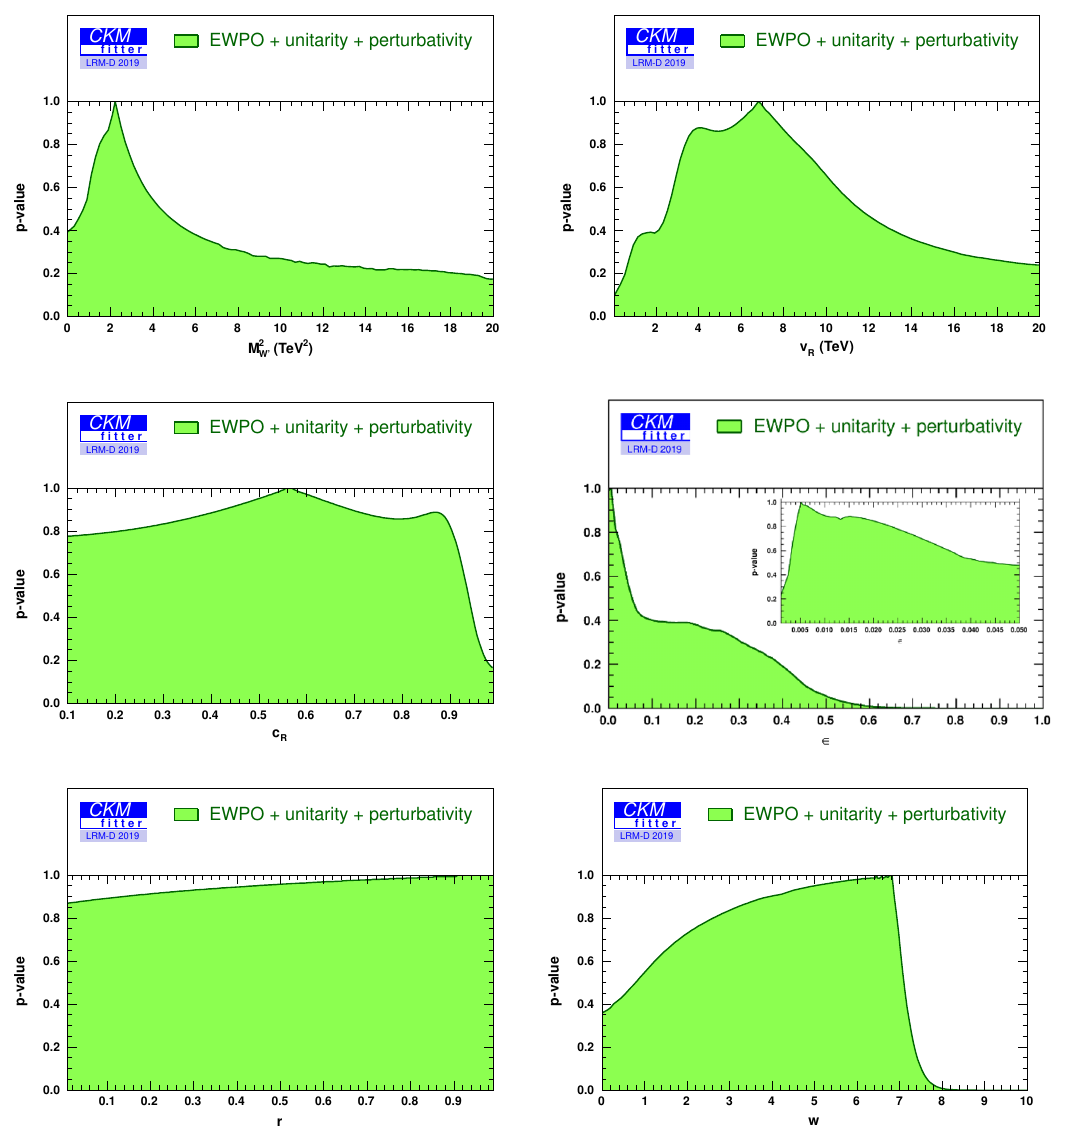
Figure 5 . The p -values for some parameters of the DLRM: the value of the parameter at the best-(cid:12)t point corresponds to a p -value of 1, while di(cid:11)erent Con(cid:12)dence Level (CL) regions are read from di(cid:11)erent values of p -value (a 1 (cid:27) CL region corresponds to a p -value of (cid:24) 0 : 33). The (cid:12)gure for the p -value of (cid:15) has an insert of a zoomed region.